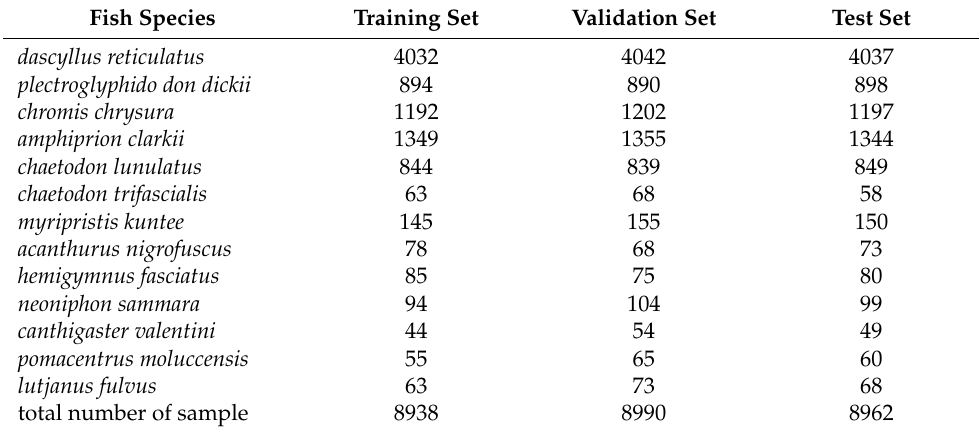
Table 1. The species used in the dataset.